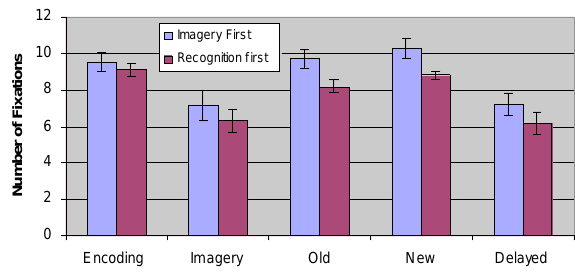
Figure 7: Differences in number of fixations between The Imagery First group and The Recognition First group and between phases of the course of the experiment.